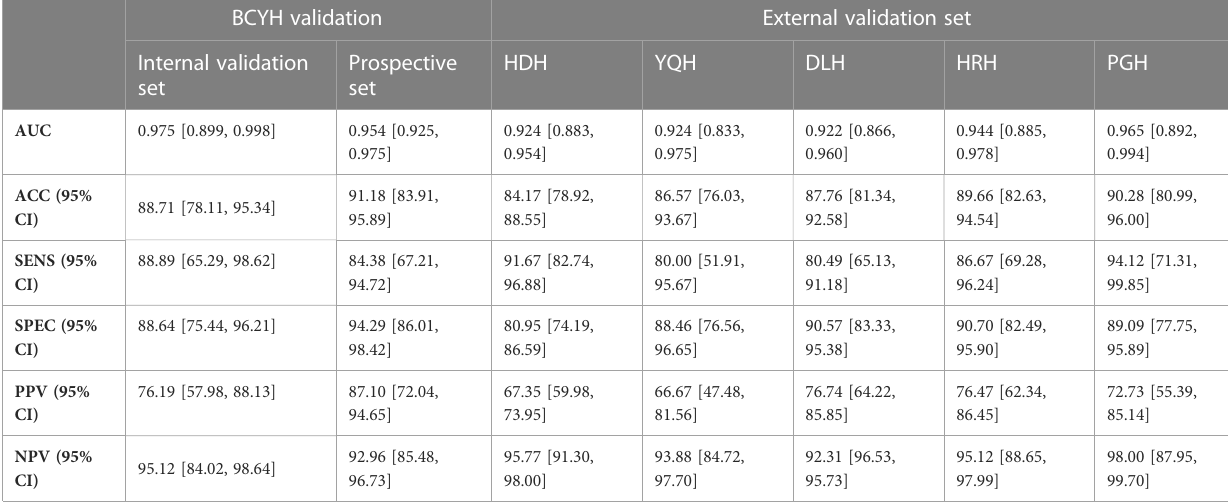
TABLE 2 Performance of IDBCS in different validation